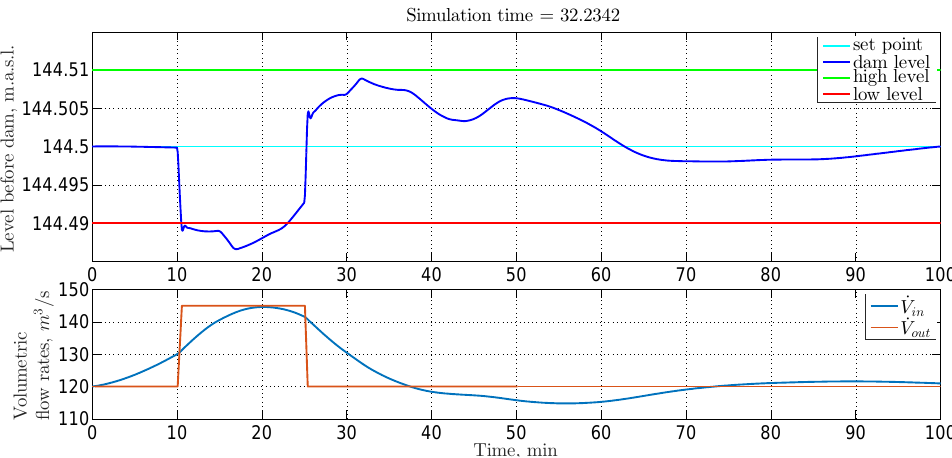
Figure 10: The results of simulation of P controller with Smith predictor ( T s = 5 and K p = 10).